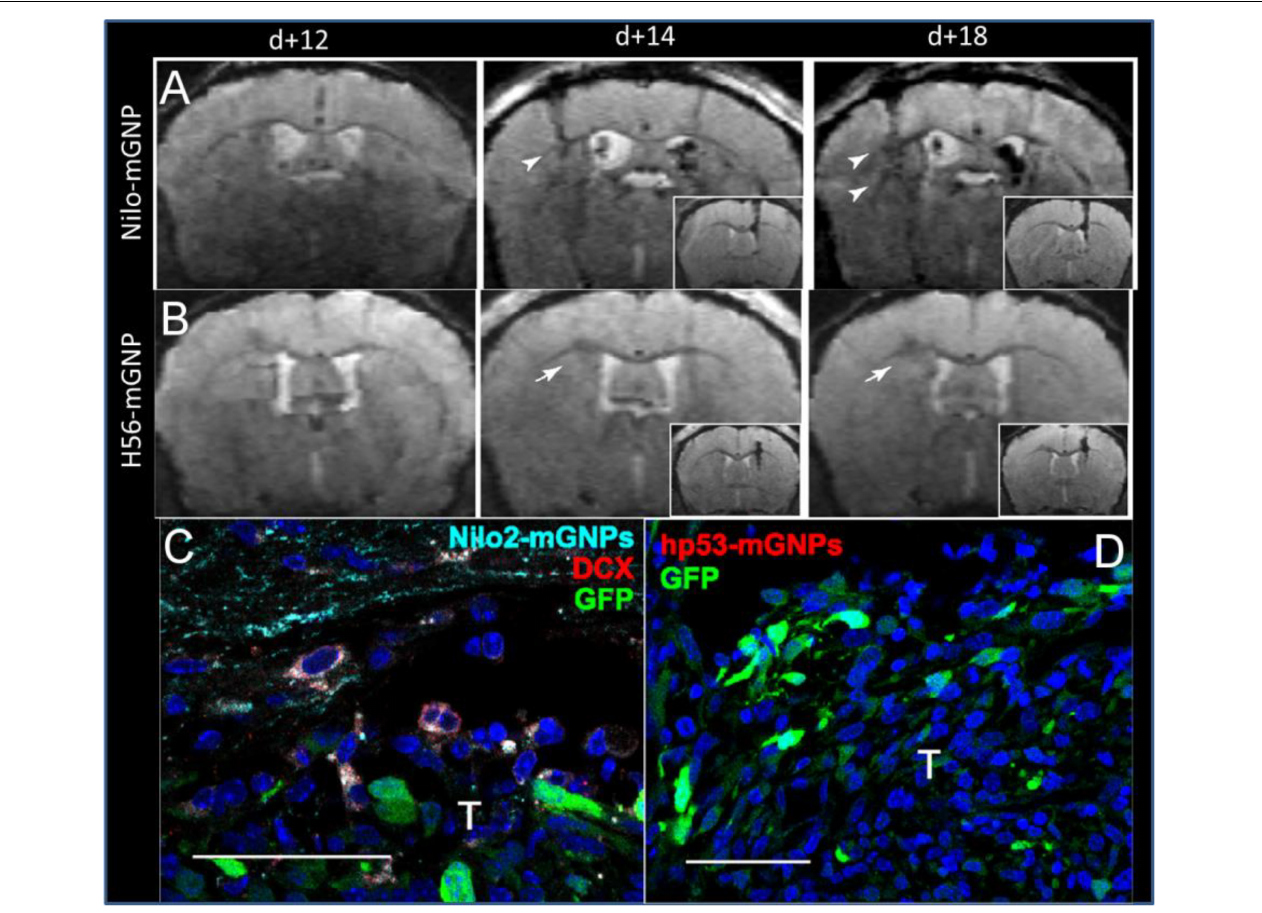
FIGURE 3 | Targeted magnetic glyconanoparticles (mGNP) specifically labeled NPC and the NPC migrated to astrocytomas. mGNP were fabricated with (A) antibodies that target NPC (Nilo) or (B) control antibodies (H56) and injected contralaterally to CT-2A astrocytoma on day 13 of tumor growth. Arrowheads indicate hypointense signal at the tumors as early as 1 day after NPC injection, while arrows indicate absence of hypointense signals. No control particles were detected at the tumor. (C) NPC (red) were labeled with the mGNP (light blue) and migrated to the tumor (green). (D) No control nanoparticle labeled cells were detected near the tumor. T, tumor, scale bar is 50 µ m (Elvira et al., 2012). Reproduced via Plos One Creative Commons Attribution (CC BY)